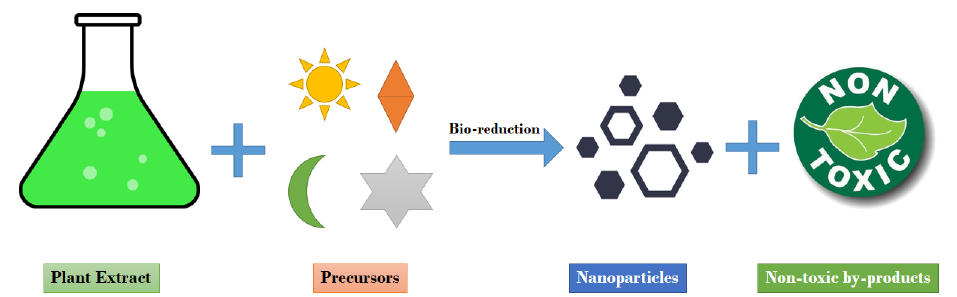
Figure 3. A suggested scheme for nanoparticle synthesis by plant extracts.